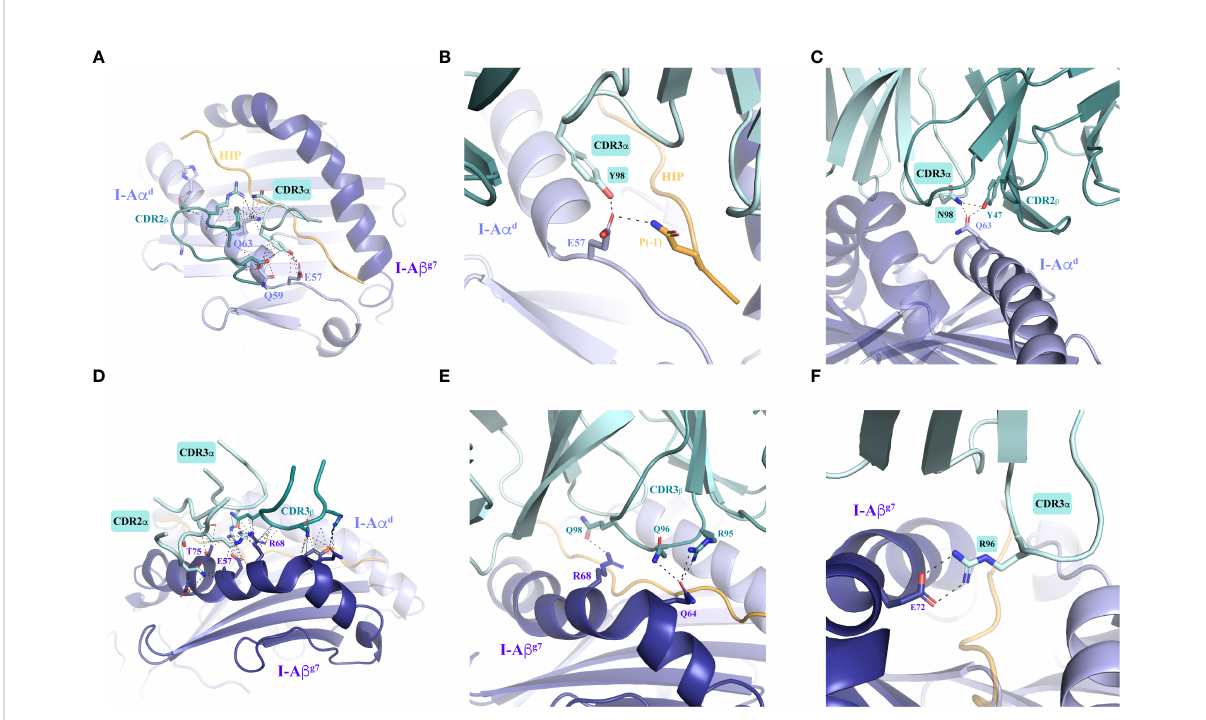
FIGURE 4 Intermolecular contacts between the 4.1-TCR and HIP39/I-A g7 . (A) Overall contacts ( ≤ 4 Å) with the TCR mediated by I-A a d , displayed as dashed lines. (B, C) Polar interactions mediated by I-A a d are shown in zoomed-in images. The panels show speci fi c interactions established by Glu57 in I-A a d with Tyr98 in the TCR CDR3 a and Gln side chain in the HIP P(-1) position ( B ) and by Gln63 in I-A b g7 with Asn98 and Tyr47 in the TCR CDR3 a and CDR2 b , respectively ( C ). (D) Overall contacts ( ≤ 4 Å) with the TCR mediated by I-A b g7 . (E, F) Polar and ionic contacts established by Arg68 and Gln64 (panel E ) in I-A b g7 with the TCR CDR3 b loop, and a close salt bridge by Glu72 with CDR3 a Arg96 side chain (panel F ). In all cases the interacting residues are highlighted as sticks. Contacts are displayed as dashed black lines. The TCR a and TCR b chains are colored pale cyan and deep teal,